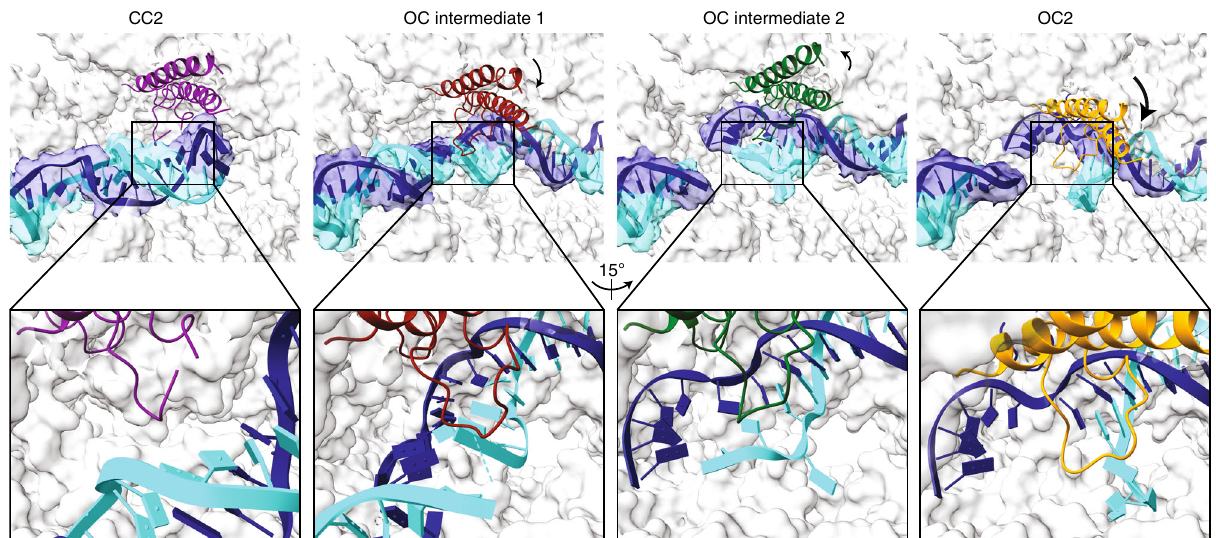
Fig. 3 Mechanism of DNA loading/melting. Pol I CC2, Pol I OC intermediate 1, Pol I OC intermediate 2 and Pol I OC2 are depicted from left to right with the rudder (A190 residues 443 – 455) shown in purple, red, green and orange ribbons. The cryo-EM density for the DNA from 6 Å low-passed fi ltered maps is shown in the upper panel; zoomed in and rotated views of the upper panel are shown in the lower panel. Initial DNA loading and formation of a small transcription bubble requires clamp closure, while further DNA promoter melting requires clamp opening and insertion of the rudder between the template and non-template